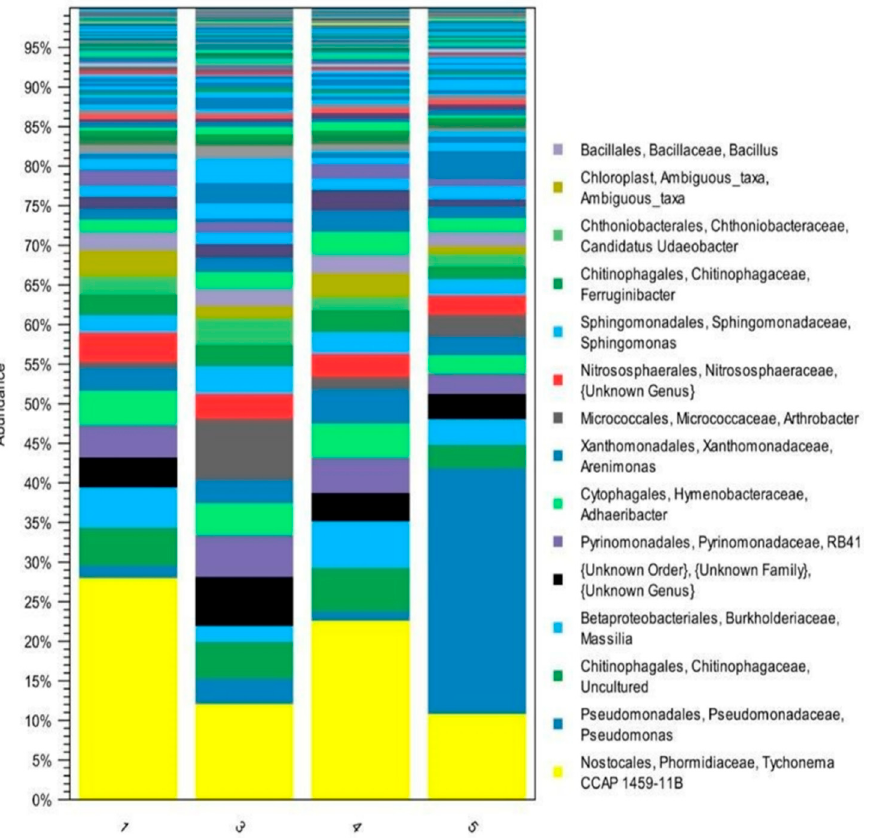
Figure 2. Graphical comparison of the bacterial abundance at the genus level for the studied sam- ples.